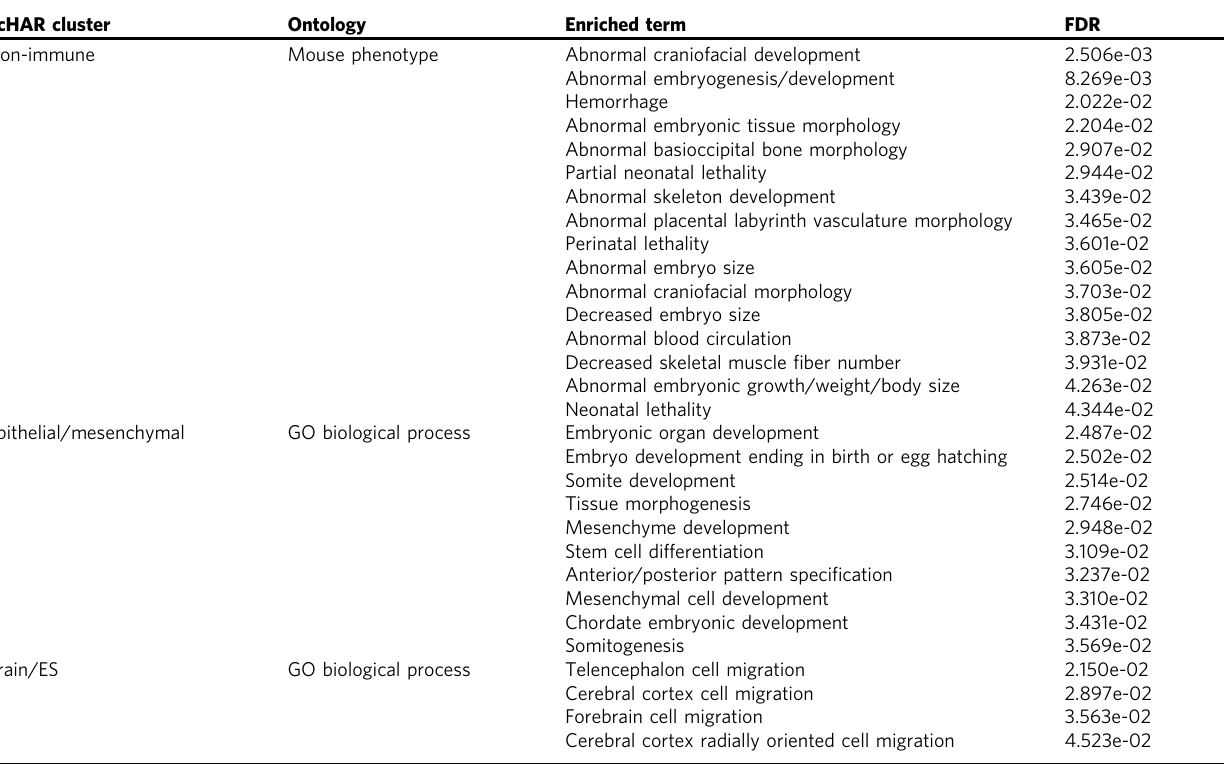
Table 2 Ontology search results are consistent with ncHAR cluster cell type identities ncHAR